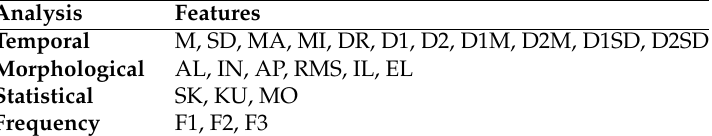
Table 2. Features obtained from skin conductance response